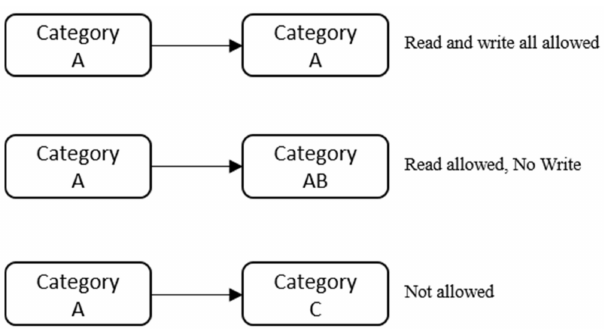
Figure 5. Security label